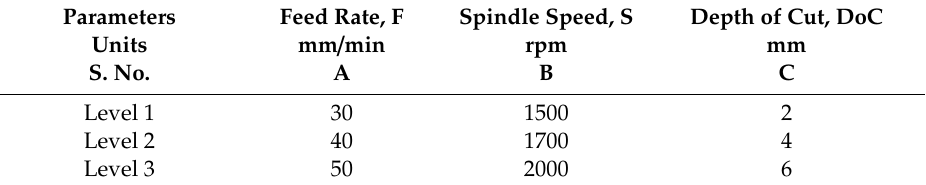
Table 2. Selected input process parameters and their levels.